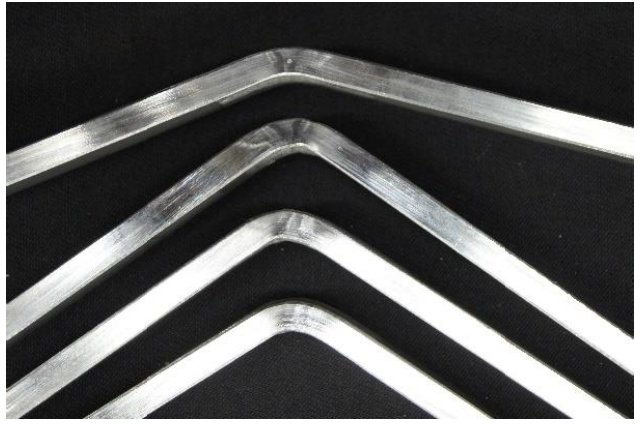
Figure 10. View of specimens after